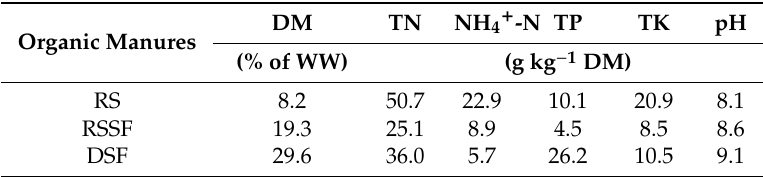
Table 1. Main characteristics of non-acidified raw dairy slurry (RS), raw dairy slurry solid fraction (RSSF), and digestate solid fraction